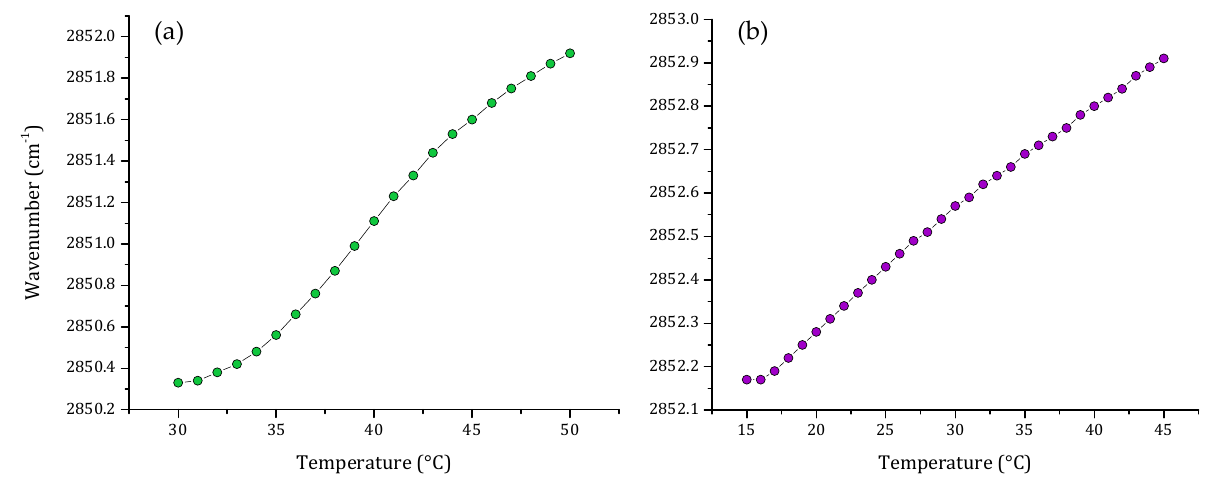
Figure 3. Peak positions of the ν s CH 2 vibration bands of the methylene groups as a function of temperature of ( a ) non-cancer cell model membrane (PC:SM:PE:CH; 4.35:4.35:1:1 w / w ) and ( b ) lipid extract of breast cancer MCF-7 cell line, both transitions were obtained using buffer (10 mM HEPES, 500 mM NaCl, 1 mM EDTA, pH 7.4).